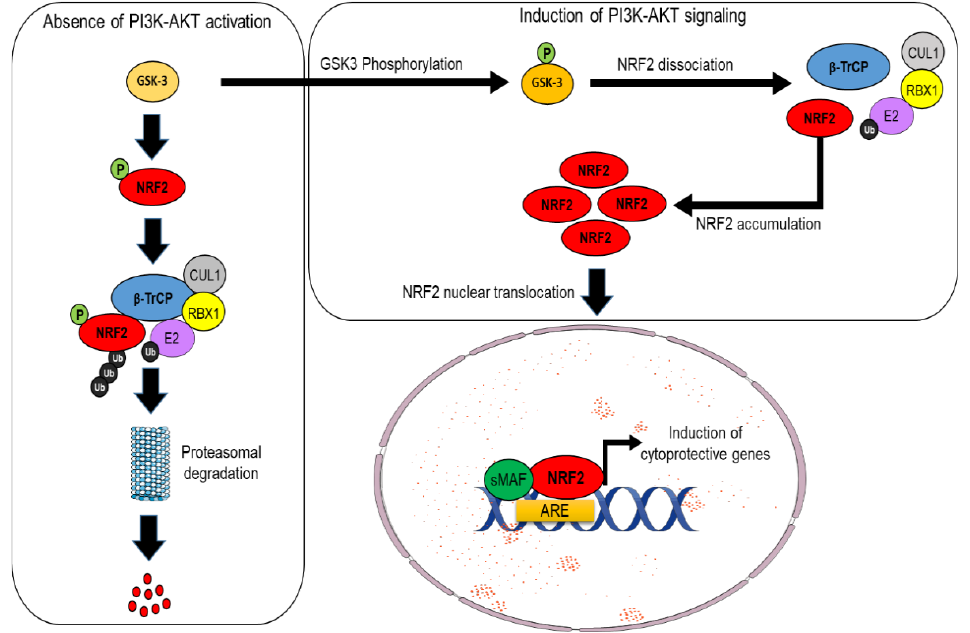
Figure 3. Non-c anonical pathway of β– TrCP dependent (KEAP1-independent) NRF2 degradation. Figure 3. Non-canonical pathway of β –TrCP dependent (KEAP1-independent) NRF2 degradation. In absence of PI3K – AKT upstream signaling, the serine threonine kinase GSK-3 phosphorylates In absence of PI3K–AKT upstream signaling, the serine threonine kinase GSK-3 phosphorylates NRF2, and this post-translational modification facilitates its recognition by the CUL1 ubiquitin E3 ligase complex which in turn primes NRF2 for proteasomal degradation. The induction of the PI3K-AKT pathway phosphorylates and inactivates GSK-3, which cannot phosphorylate NRF2. This prevents NRF2 recognition by the CUL1 ubiquitin E3 ligase complex and promotes its accumulation. NRF2 then enters into the nucleus, heterodimerizes with members of the small Maf proteins, and induces the expression of target cytoprotective